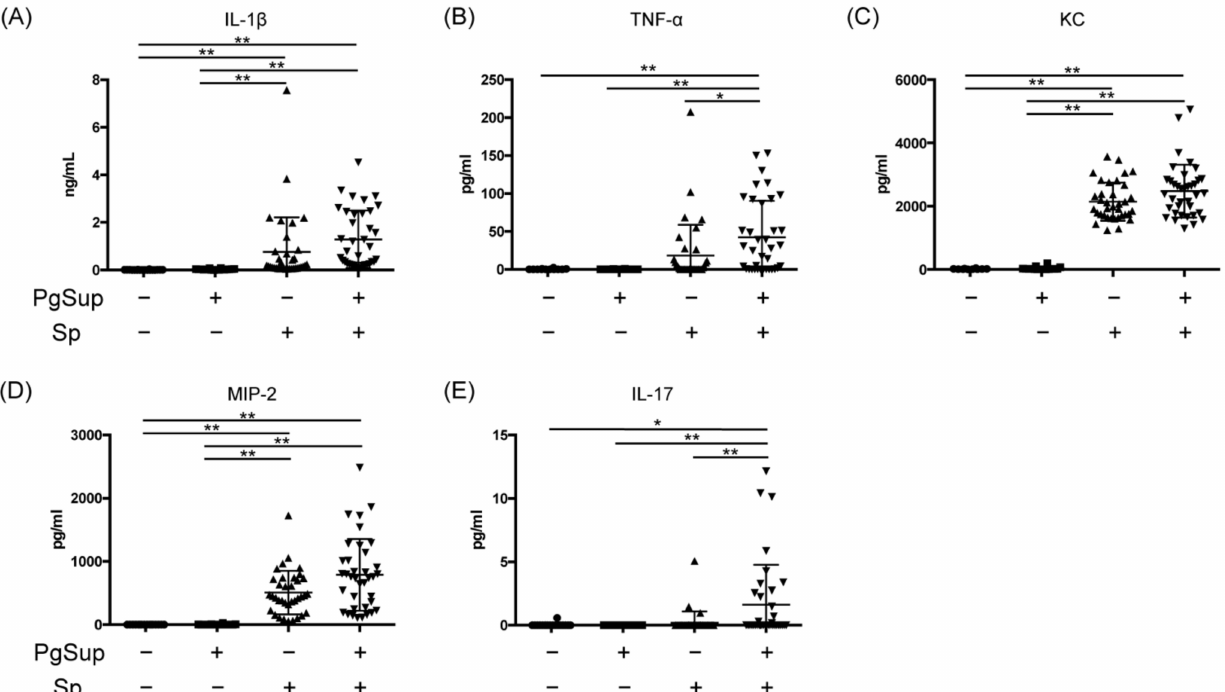
Figure 5. The production of IL-1 β , TNF- α , KC, MIP-2, and IL-17 in Sp-infected mice inoculated with or without PgSup. The supernatants obtained by centrifugation of lung homogenates of each group were compared for ( A ) IL-1 β , ( B ) TNF- α , ( C ) KC, ( D ) MIP-2, and ( E ) IL-17 production by ELISA. “+” indicates the presence of PgSup or Sp, and “ − ” indicates the absence of PgSup or Sp. Each point represents an individual mouse. Each group was analyzed by one-way ANOVA, and data are presented as the mean ± SD. Significant differences were analyzed using the Kruskal–Wallis test (* p < 0.05, ** p <